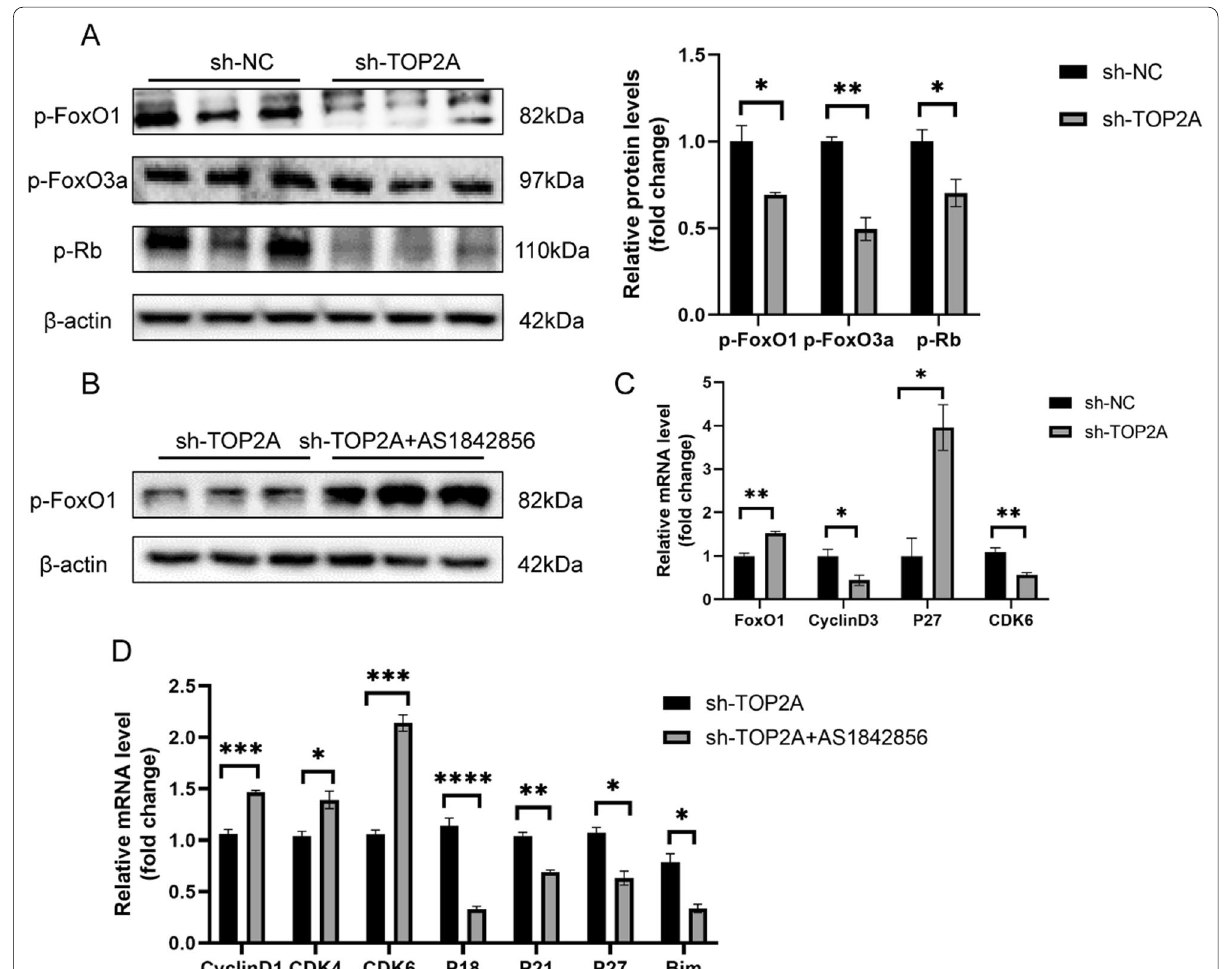
Fig. 6 Downregulation of TOP2A affects the FOXO signaling pathway. A Western blotting showed changes in the levels of phosphorylated- FoxO1, phosphorylated-FoxO3a and phosphorylated-Rb after TOP2A downregulation. B Western blotting was used to assess changes in the level of phosphorylated-FoxO1 in the inhibitor-treated group. C q-PCR assay was used to verify changes in the mRNA expression of several downstream signaling molecules. D mRNA expression of cycle-associated genes was assessed after TOP2A knock down in JEG-3 cells and after treatment with